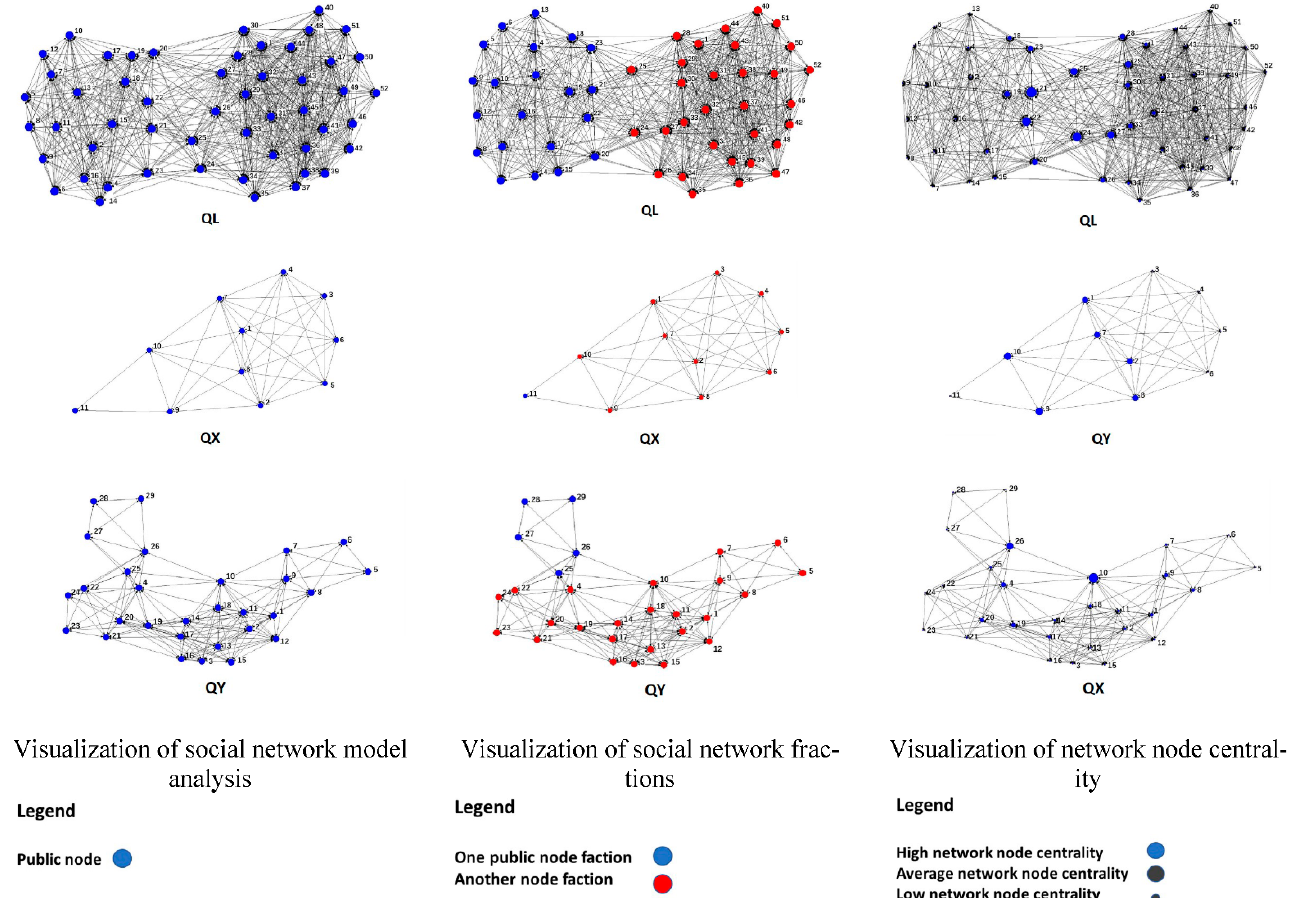
Figure 5. Visualization of social network model of sample affordable housing’ internal public space.